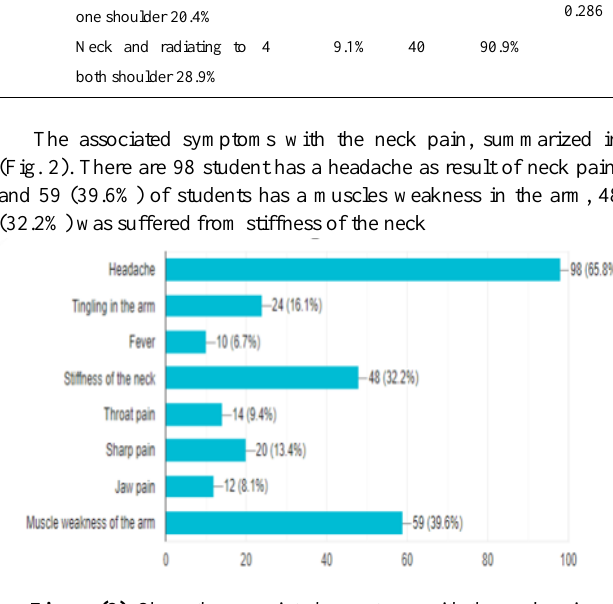
Figure (2) : Show the associated symptoms with the neck pain